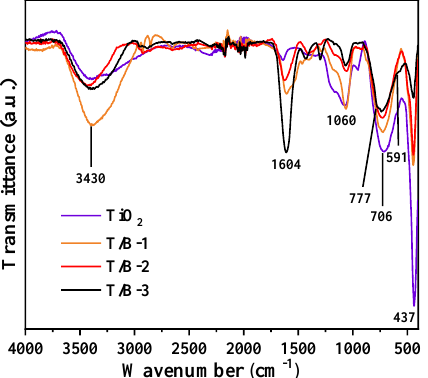
Figure 8. FTIR detection spectra of TiO 2 , T/B-1, T/B-2, and T/B-3 composite fibers.